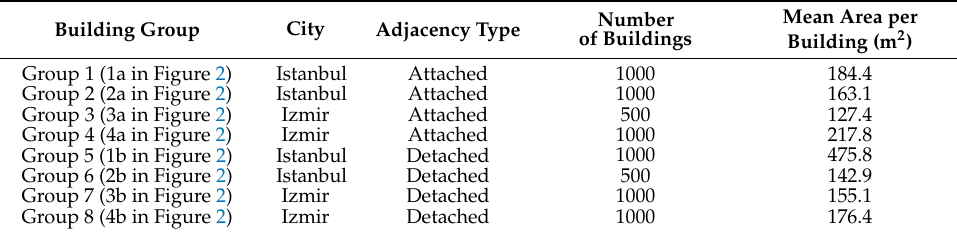
Figure 2. Attached ( a ) and detached ( b ) buildings. Table 1. The statistics of building